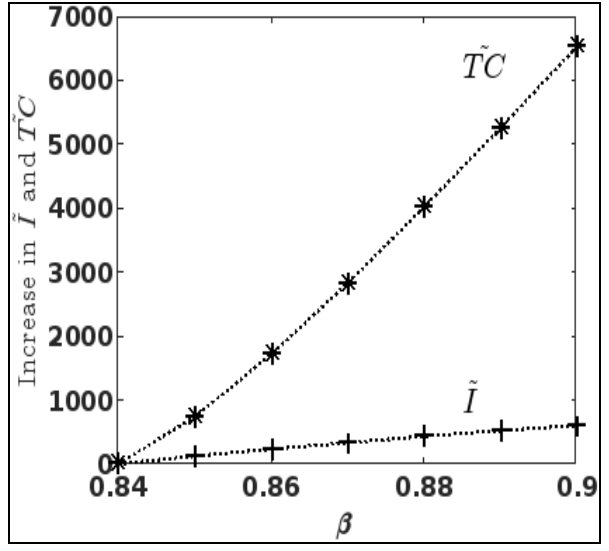
Figure 3. Effect of inflation rate on optimizing the total cost and ordering quantity.